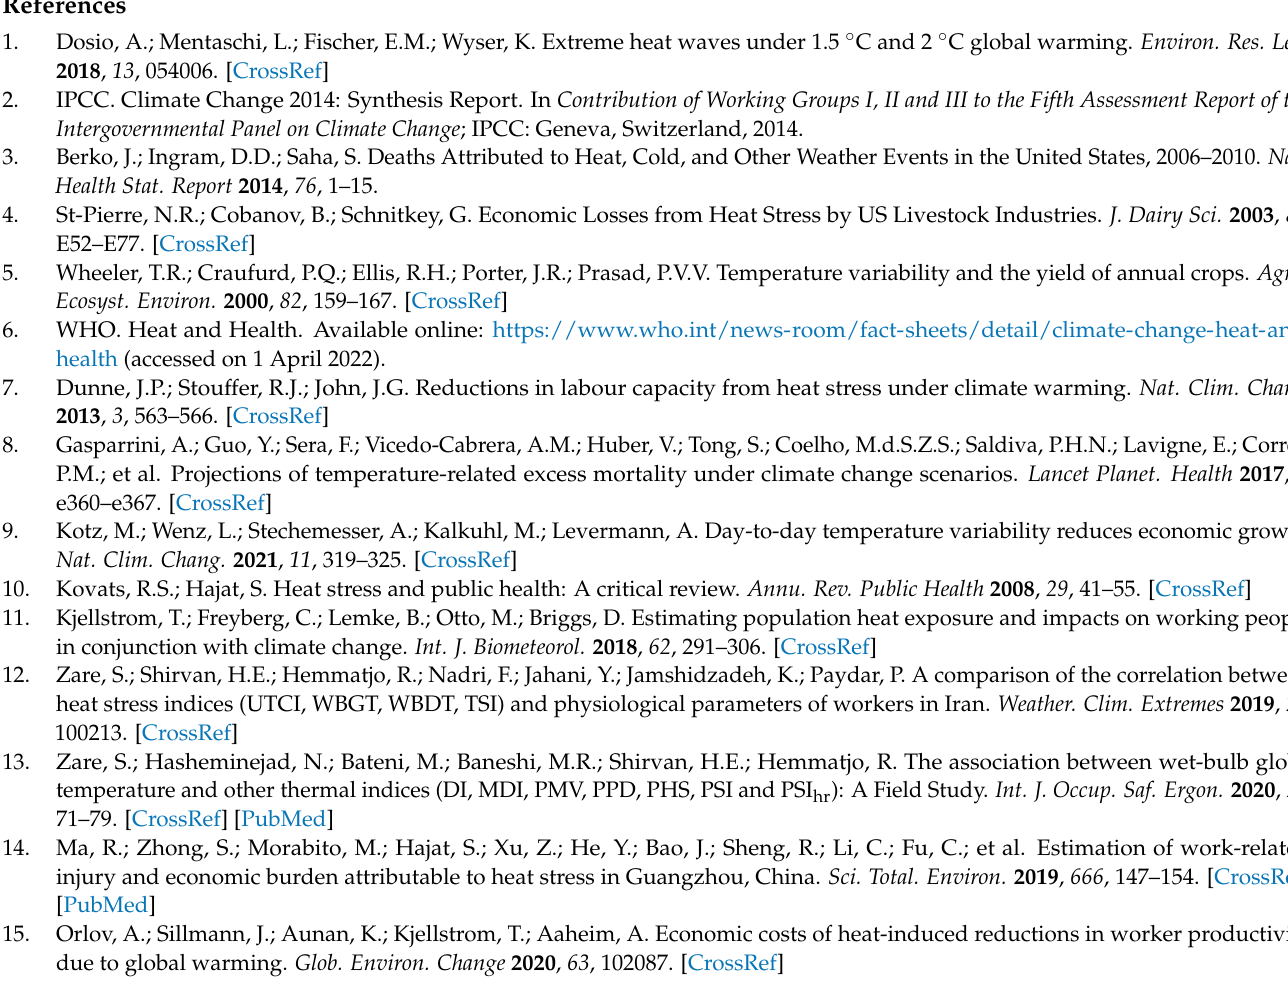
Figure A3. Normalized monthly mean latent heat flux ( y -axis) vs. rest hour ( x -axis) during 2010–2019 for New Delhi, Kathmandu, and Dhaka.